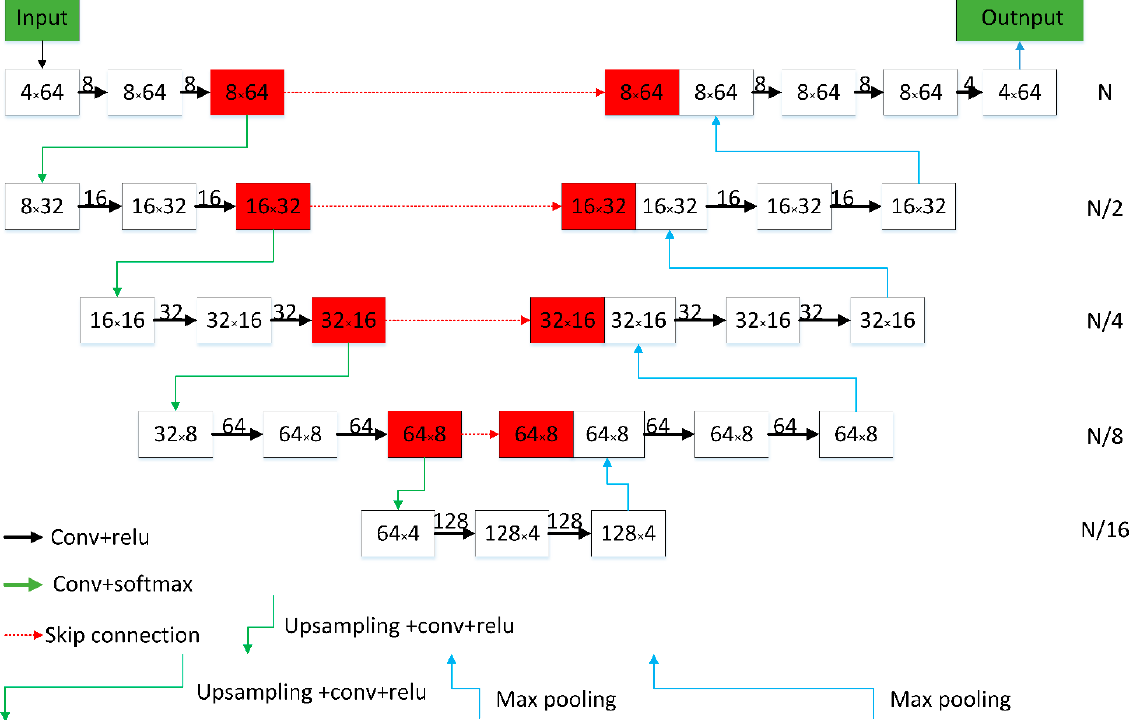
Figure 5. U-net architecture with a depth of 5, which was used for heart sound segmentation. The number in the boxes indicates the feature dimension of the corresponding layer. The number on the arrow of the diagram represents the filter size. The number on the right side of the diagram represents the length of the input and output of each convolutional layer.